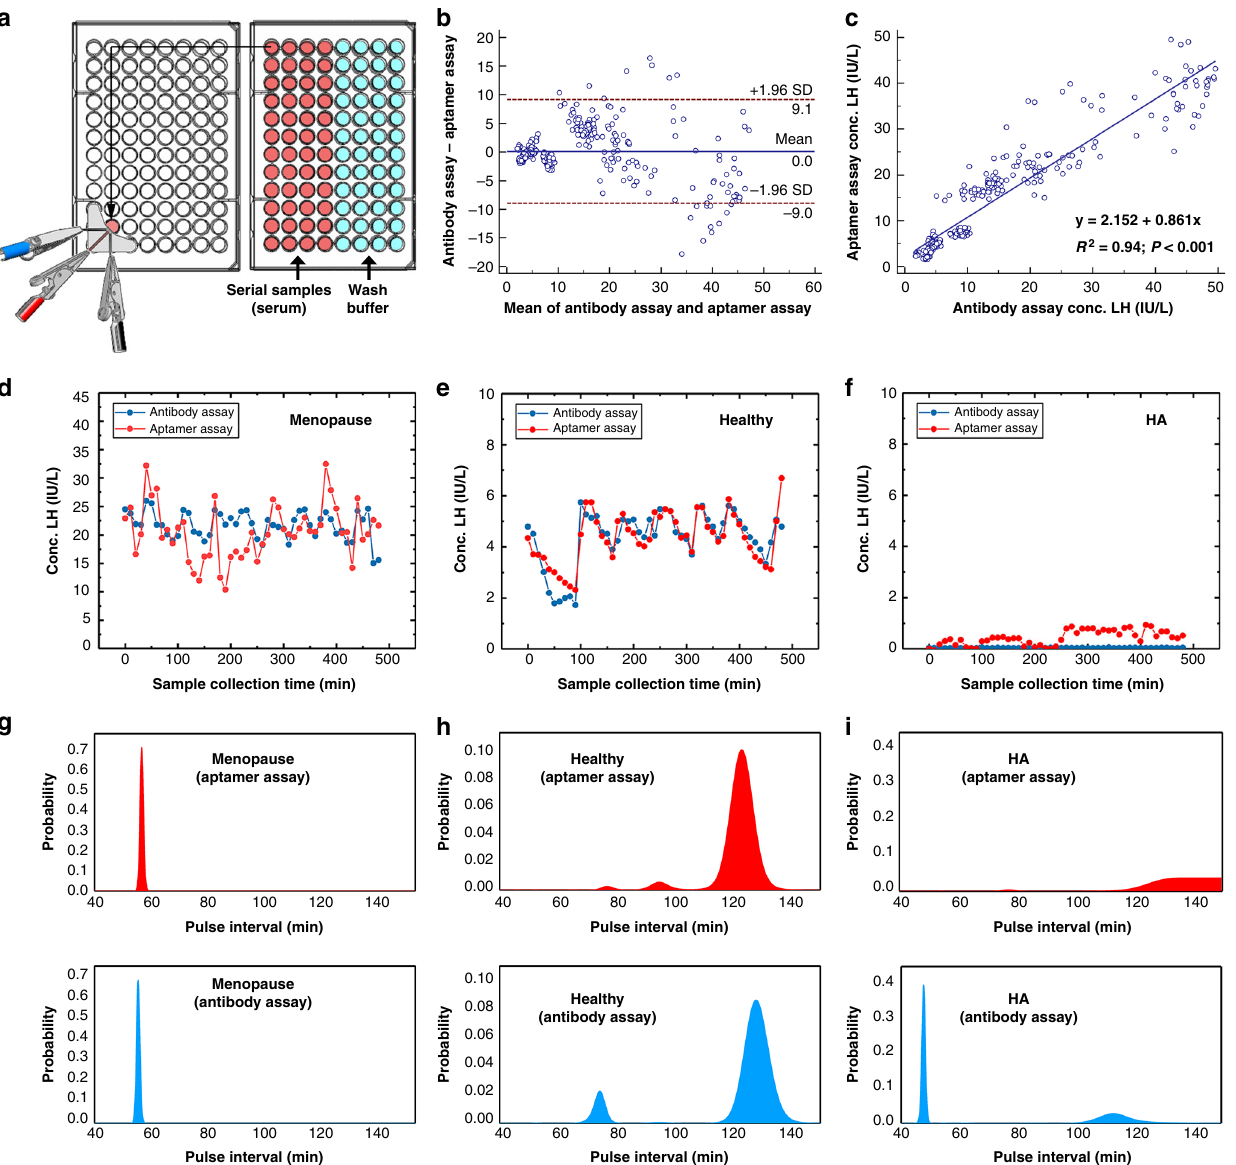
Fig. 5 Distinguishing patient cohorts by LH pulsatility pro fi les using RAPTER and BSA. a RAPTER setting for the measurement of clinical samples. Illustration of the measurement programme design. b Bland – Altman analysis for the comparision of clinical assay result and aptamer assay result. c Linear regression of all the datasets in three patient cohorts for the comparison of RAPTER performance with clinical standard immunochemical assay. d – f Individual LH pulsatility pro fi les in women with menopause ( d ), healthy females ( e ) and hypothalamic amenorrhoea ( f ) obtained by RAPTER (red) and clinical assay (blue). g – i Pulse interval analysis in women with menopause ( g ), healthy females ( h ) and hypothalamic amenorrhoea (HA) ( i ) obtained by RAPTER (red) and clinical assay (blue). Source data are provided as a Source Data fi le